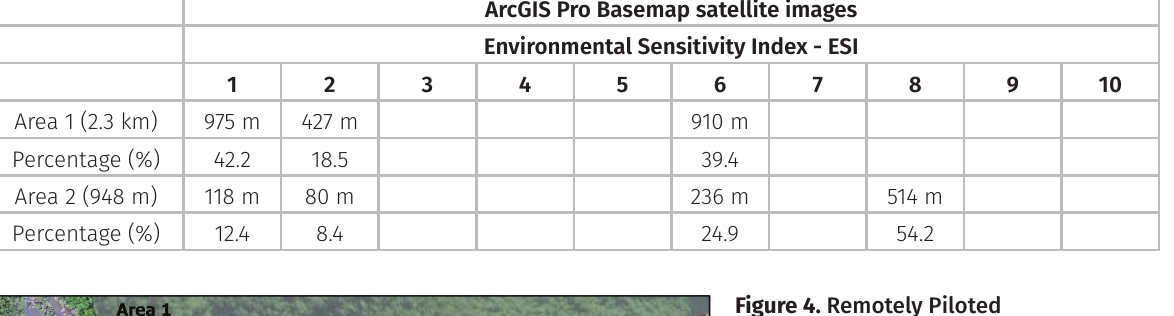
Figure 4. Remotely Piloted